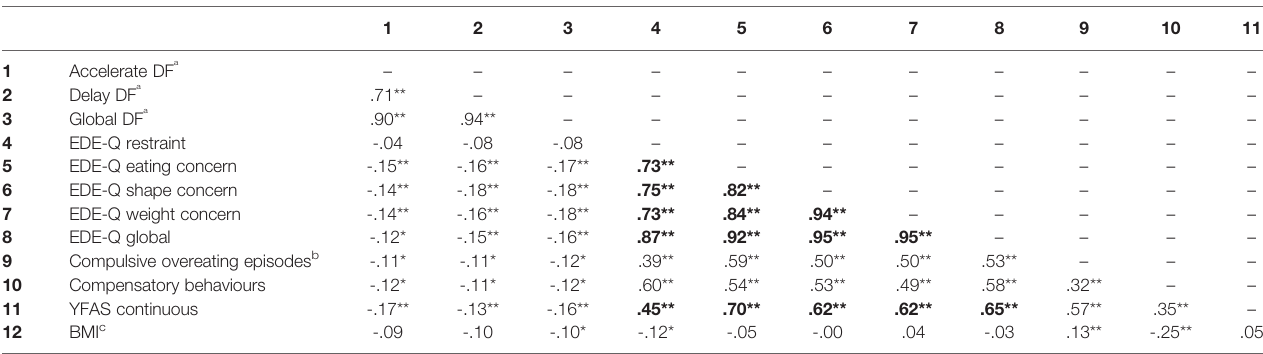
TABLE 3 | Correlations between temporal discounting rates and clinical